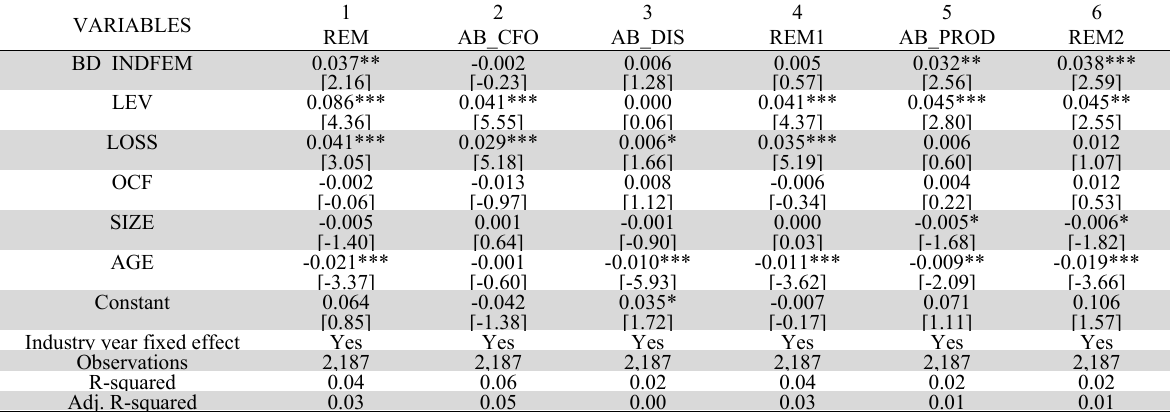
The results of the regression analysis